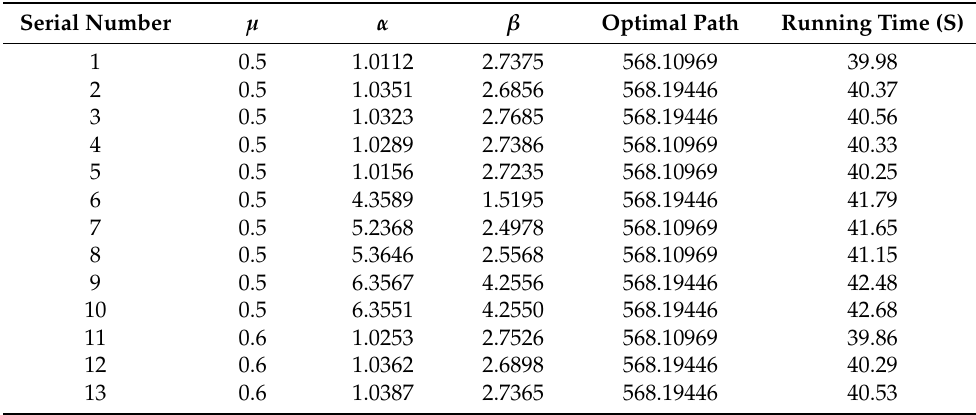
Table 3. Parameter combination test